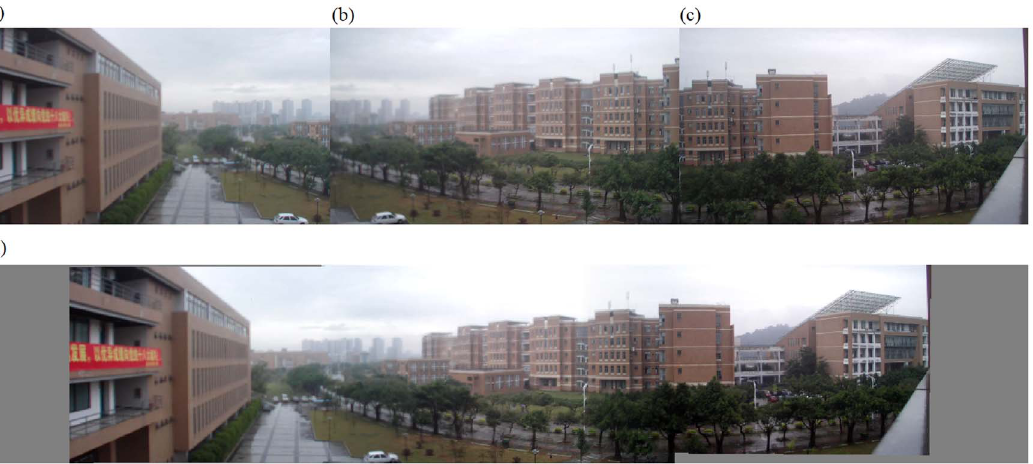
Figure 12. Experiments on the entire image-stitching algorithm (V): (a) Video image 1; (b) Video image 2 (reference image); (c) Video image 3; (d) Generated video panoramic image.